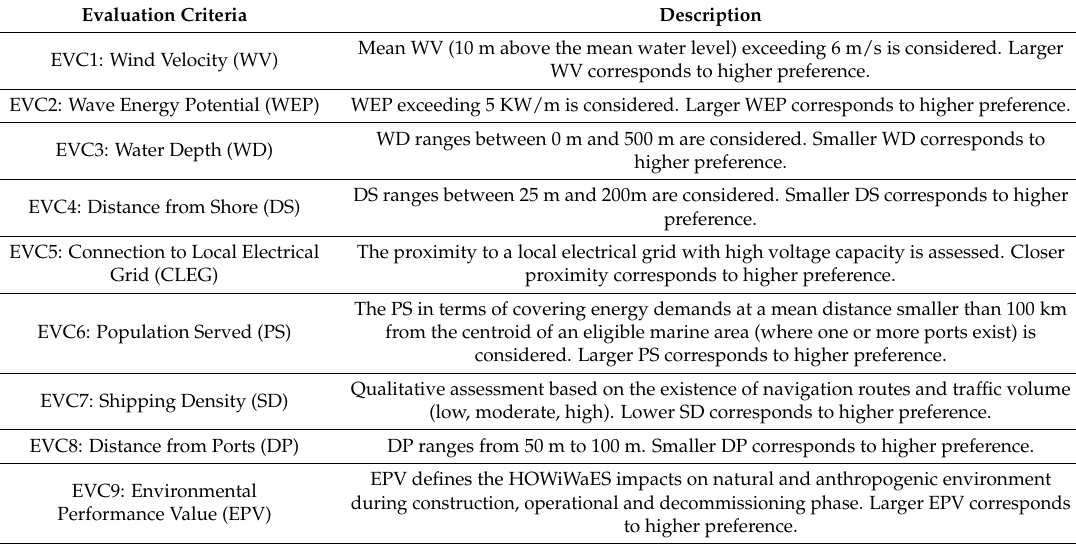
Table 3. Evaluation criteria for HOWiWaES siting in